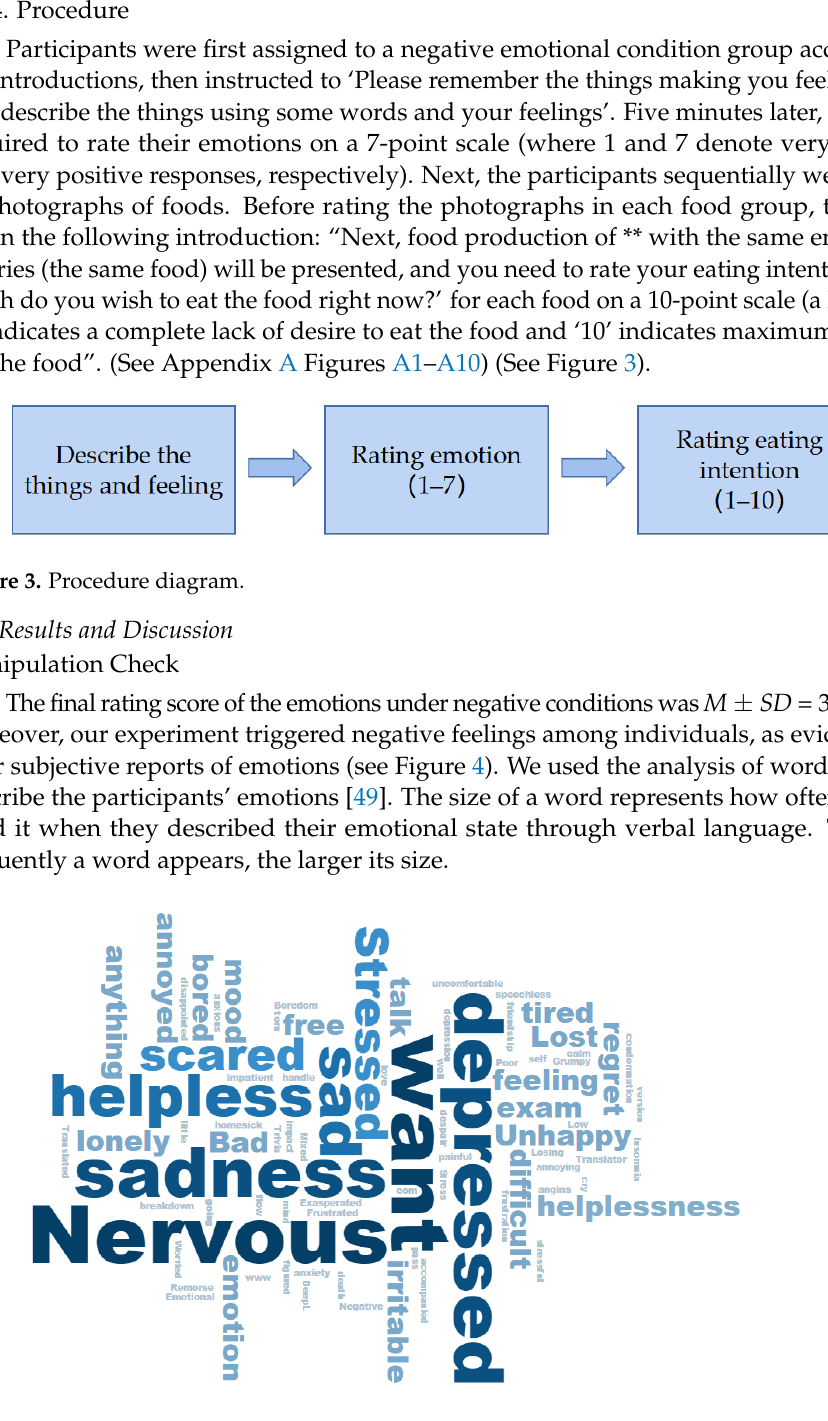
Figure 4. Profiles of negative emotions among participants.